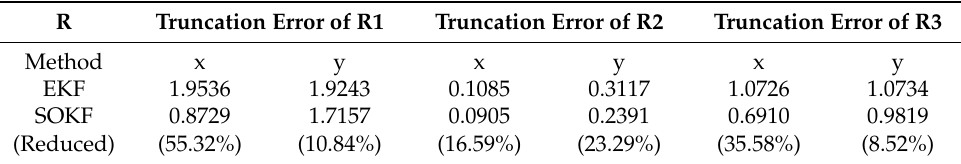
Table 2. Truncation error of trajectory estimation in fixed-formation multi-robot.